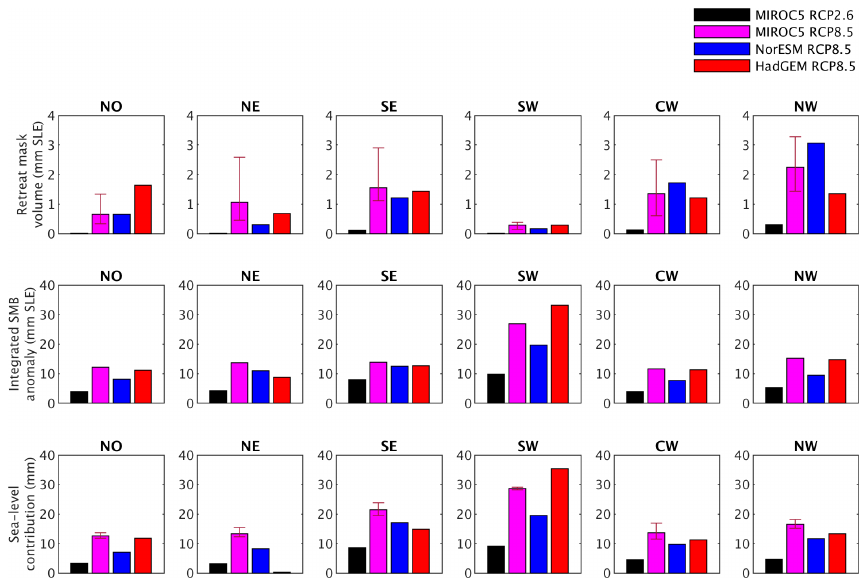
Figure 10. Ocean and atmospheric forcing and sea-level response. (a) Volume instantaneously removed by the prescribed tidewater glacier retreat mask when applied to the observed geometry (Morlighem et al., 2017). (b) Integrated surface mass balance anomaly forcing over the observed geometry. (c) Ensemble mean sea-level contribution for all models using the standard forcing approach. Bars in (a) and (c) are for low and high ocean sensitivity. Note the different vertical scale for (a) compared to (b) and (c) .